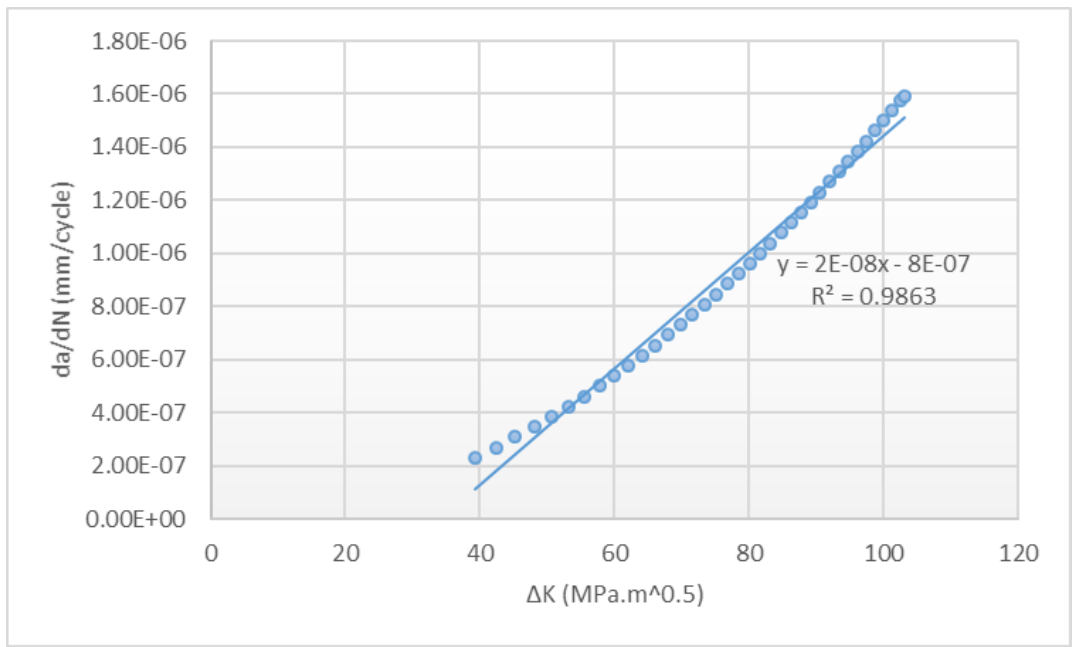
Figure A16. Stress intensity factor (∆K) vs. fatigue crack growth (da/dN) as estimated by the Bates and Clark equation.